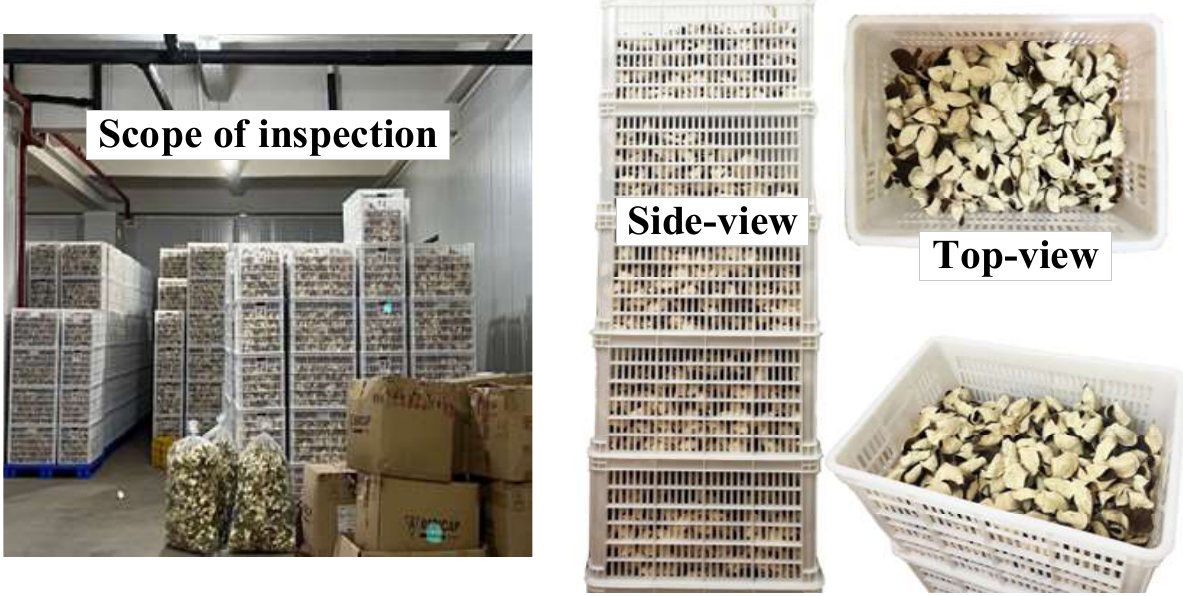
Figure 1. Common storage method and storage container of PCRC manufacturers in Xinhui.